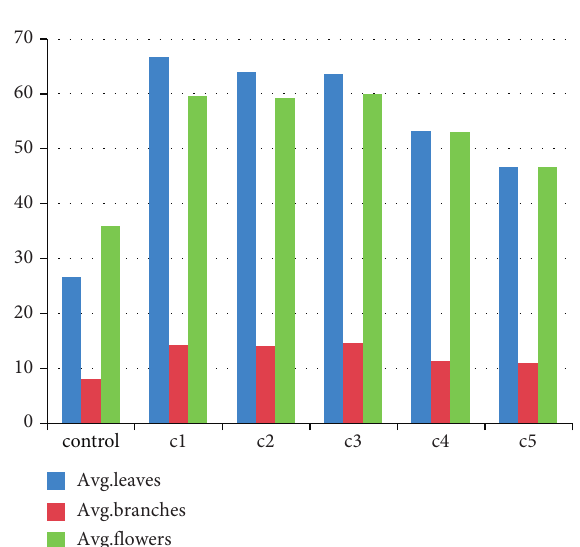
Figure 3: The overall average morphology of Phaseolus vulgaris.